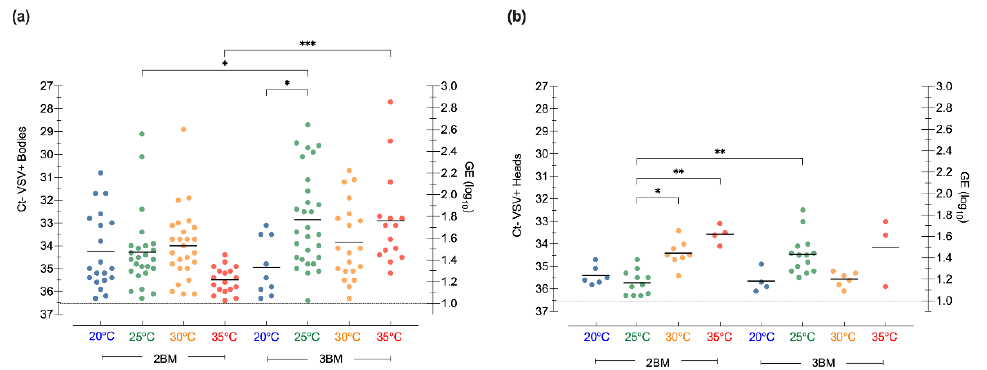
Figure 3. Constant temperature-mediated effects on VSV in individual ( a ) bodies and ( b ) heads with salivary glands, as detected by RT-qPCR of VSV-infected Culicoides midges after a second (2BM) and third (3BM) blood meal while being held at constant temperatures of 20 °C (blue), 25 °C (green), 30 °C (orange), and 35 °C (red). RT-qPCR cycle threshold (Ct; left Y-axis) and viral genome equivalents (GE; right Y-axis), as indicated. One-way ANOVA (bodies) and the Kruskal–Wallis test (heads) with multiple comparisons were used to determine statistical significance, as indicated (* p ≤ 0.05; ** p < 0.01; *** p < 0.001).